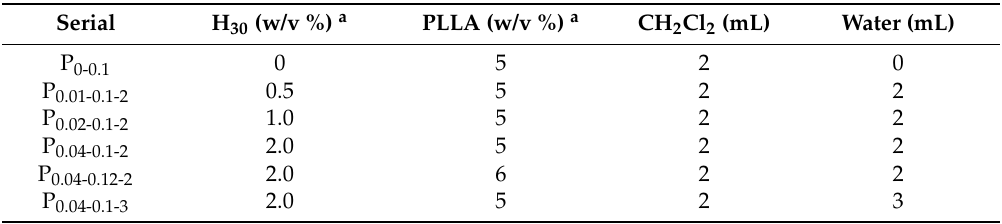
Table 1. Recipes of the different Pickering